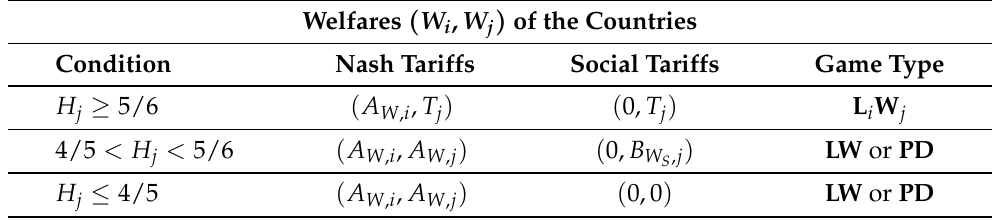
Table 1. Comparison between the welfares of the two countries with the Nash tariffs and with the social tariffs, where H i and H j are the home production indexes satisfying 0 < H i < 2/3 < H j < 1 (see Equation (11)). Reproduced from [27].